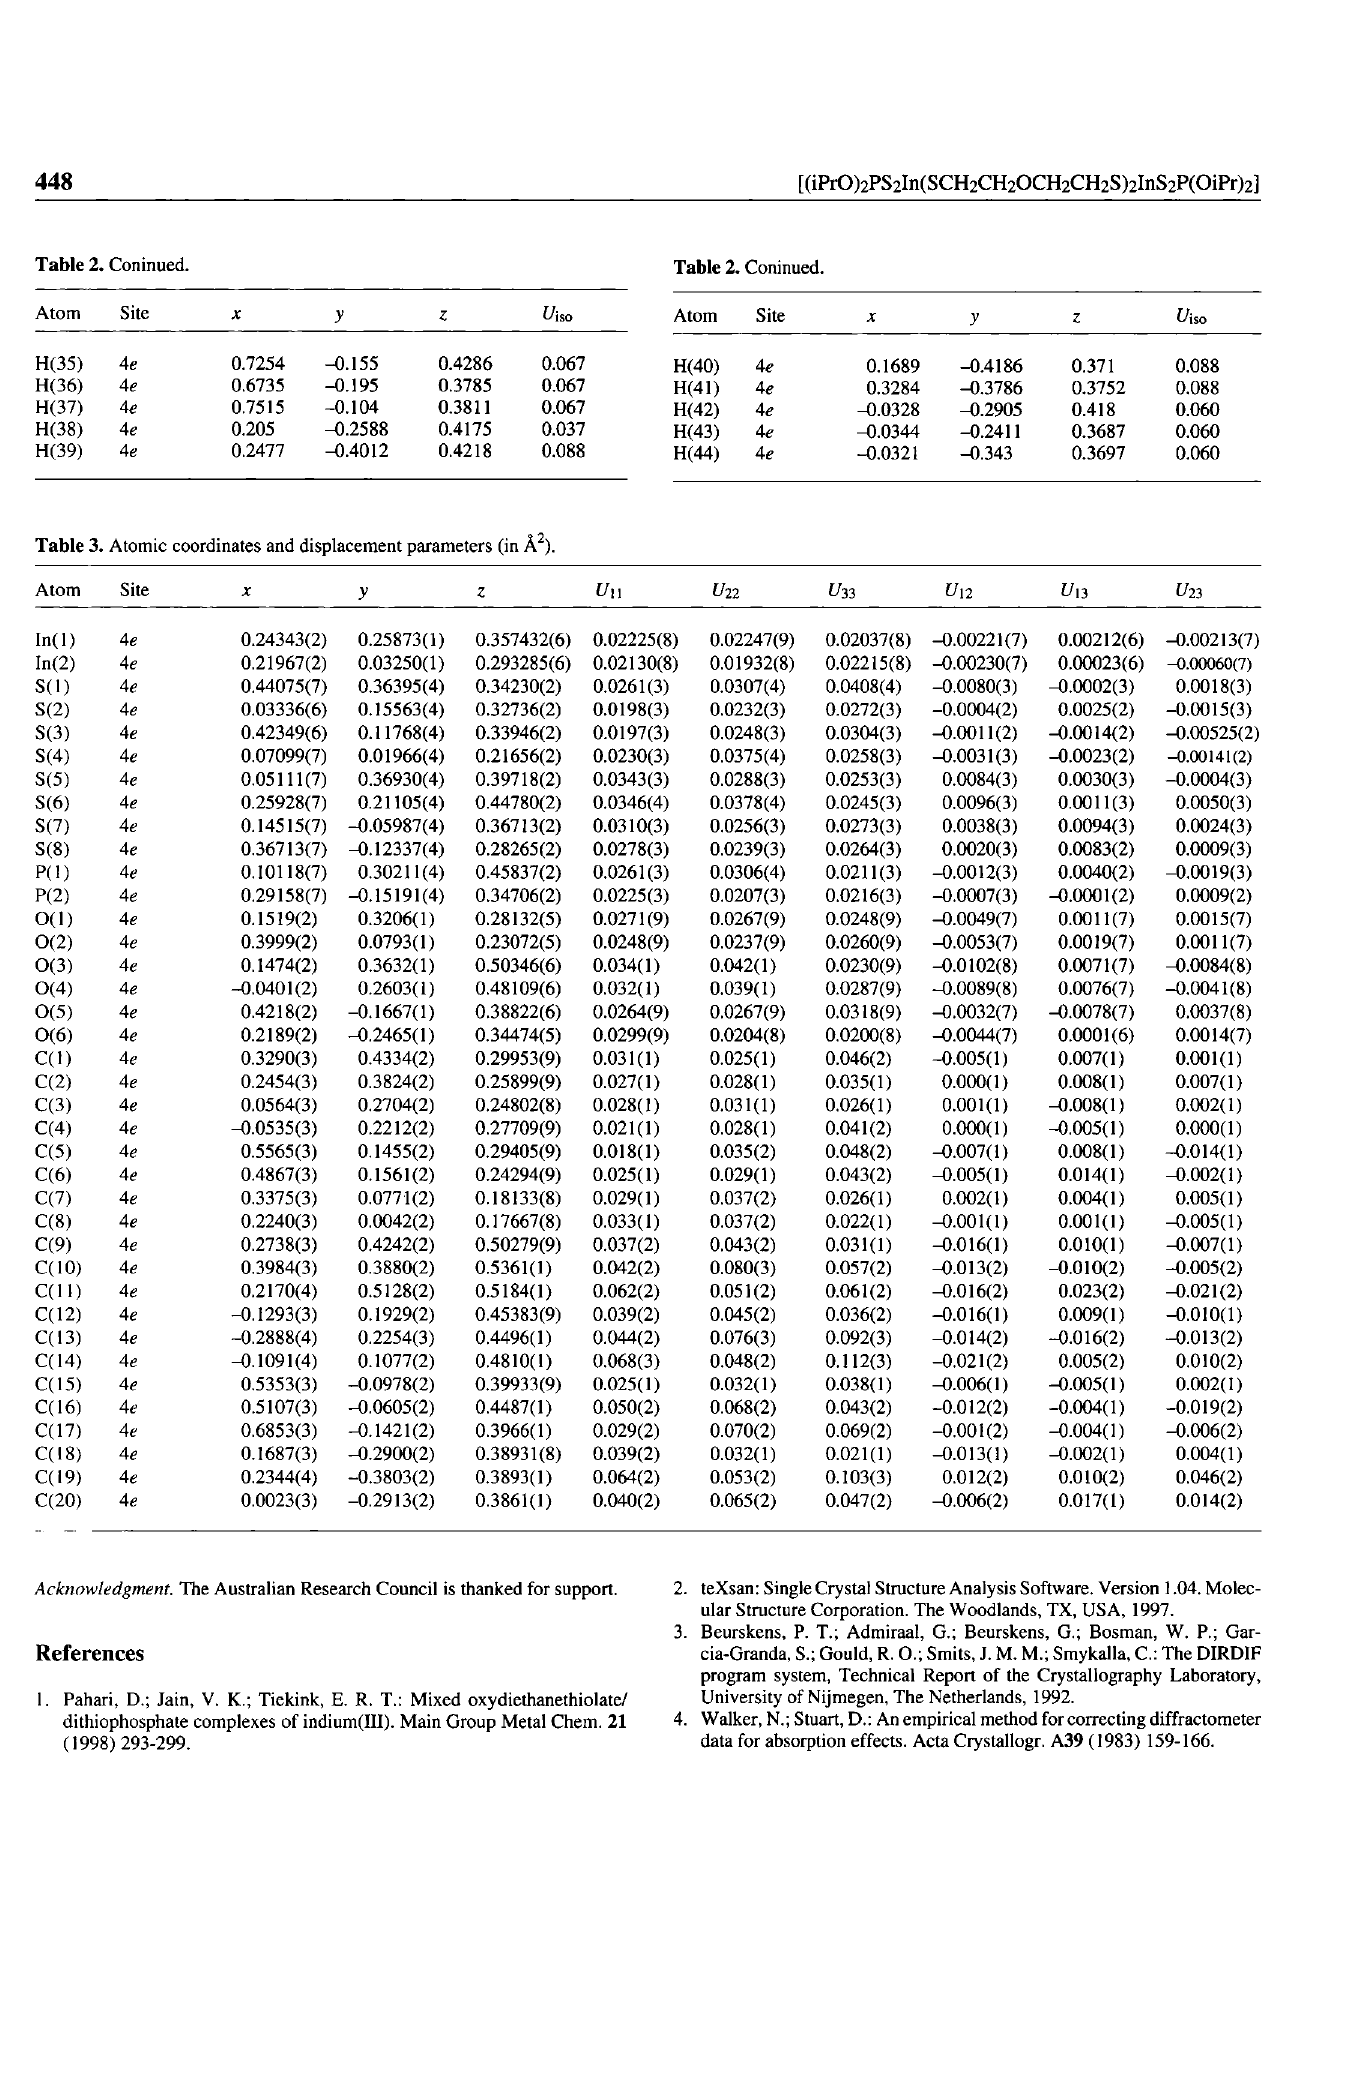
Table 3. Atomic coordinates and displacement parameters (in Ä 2